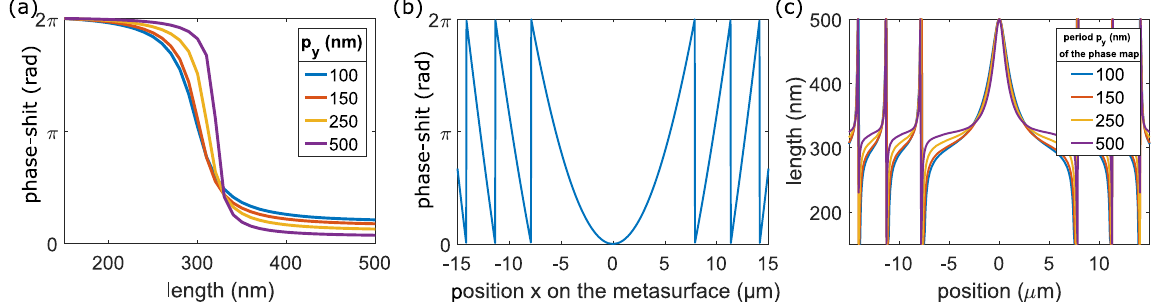
Figure 2. ( a ) Phase-maps for different periods p y (100, 150, 200, 500 nm): Phase shift provided by an element at 200 THz as a function of the length of the element. ( b ) Phase shift required as a function of the position, to design a lens of 30 μ m width with a focal length of 20 μ m at 200 THz. ( c ) Length of the elements as a function of the position to design the lens. Curves are obtained from ( a ) and ( b ) for different periods p y (along the short dimension of the